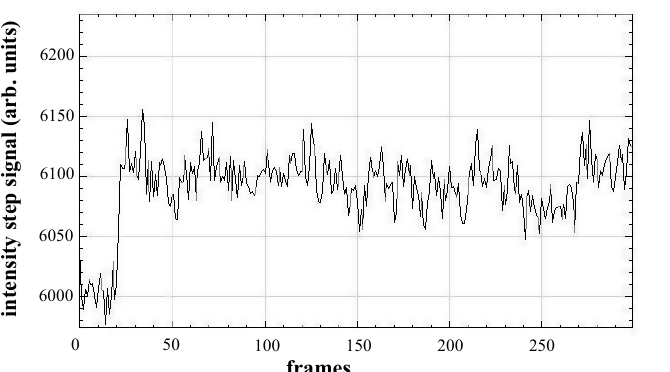
Figure 6. A typical profile of a local image intensity change caused by the binding of a 200nm silica nanoparticle bound to the gold sensor surface of the modified SPR microscopy instrument. Adapted from